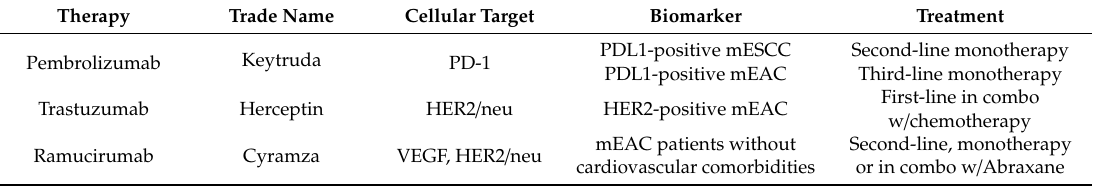
Table 1. Approved targeted therapies and associated biomarkers in esophageal